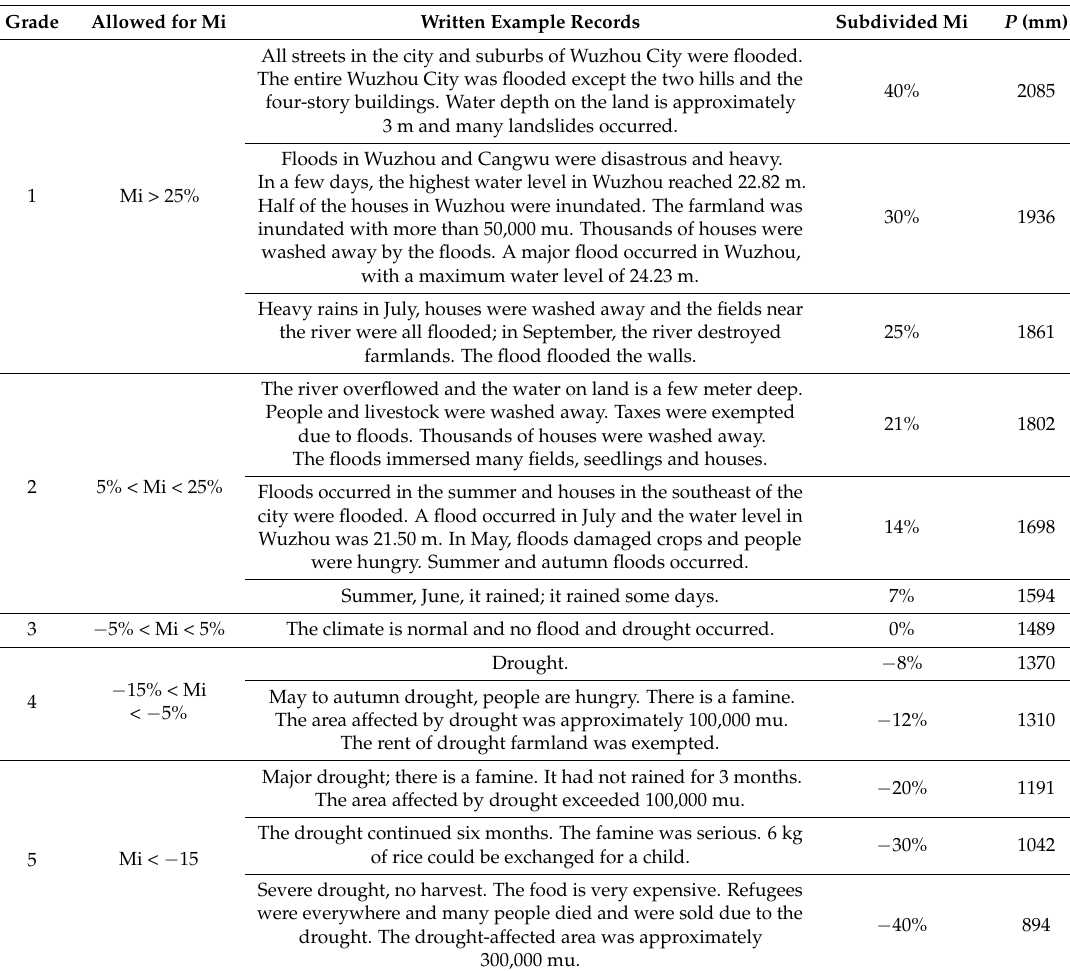
Table 3. Precipitation classification standards in Wuzhou